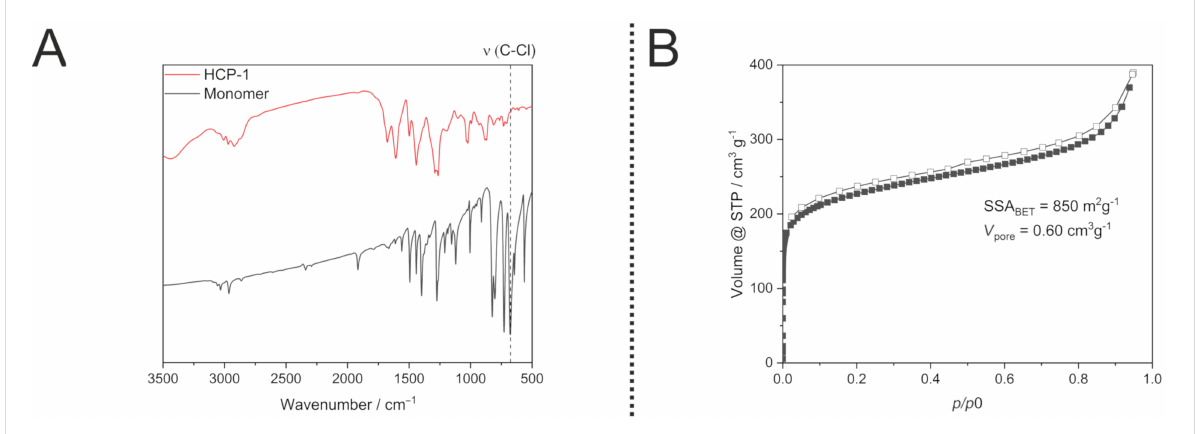
Figure 2: A: IR spectra of the monomer BCMBP and NG-HCP showing a decrease of the C–Cl vibration after the reaction. B: Low pressure nitrogen isotherm of NG-HCP demonstrating the textural properties.